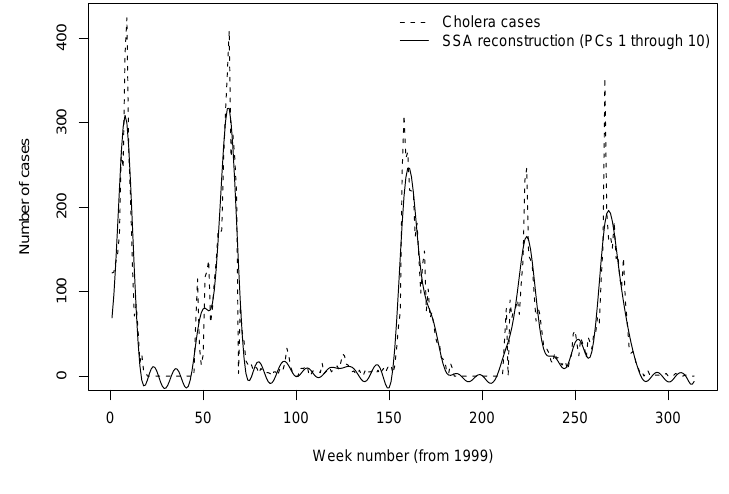
Figure 4: Cholera cases, reconstructed using